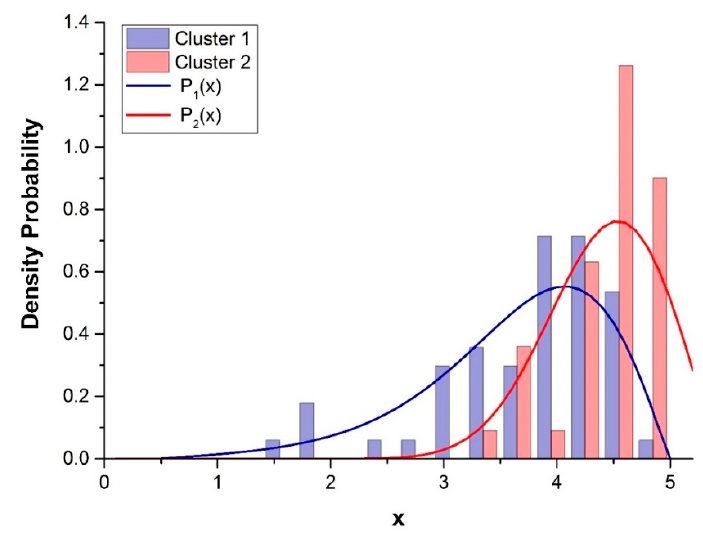
Figure 5. Distribution functions P 1 (x) and P 2 (x) (Equations (3)–(5)) for Clusters 1 and 2; x = Log (T T ) .